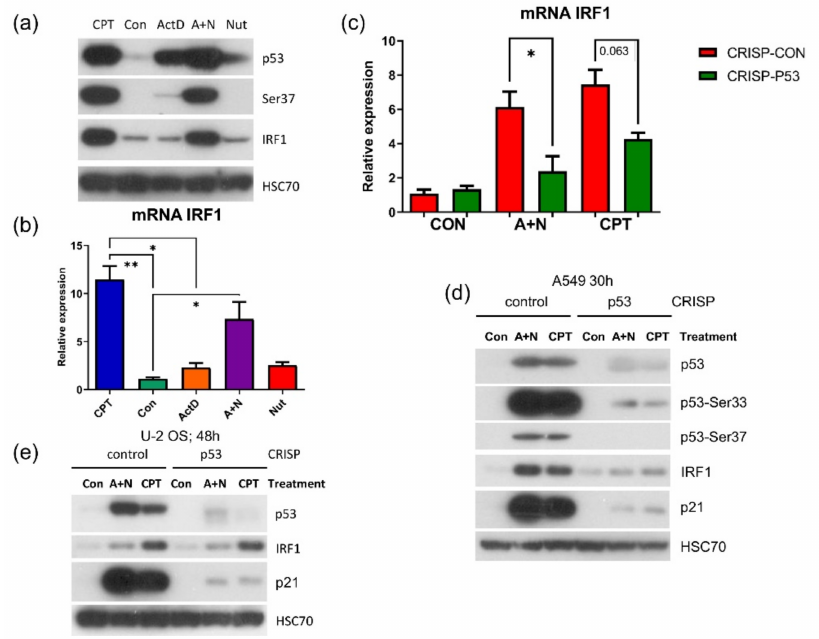
Figure 10. In A549 cells p53 participates in the induction of IRF1 transcription factor. ( a ) Western blot demonstrating expression of p53, its form phosphorylated on Ser37 and of IRF1 protein in A549 cells treated as indicated for 48 h. ( b ) Measurement of relative IRF1 mRNA level in A549 cells exposed to indicated substances or their combinations for 30 h. Statistical differences in expression was calculated by Kruskal-Wallis statistic test with uncorrected Dunn’s test (* p < 0.05) ( c ) Relative IRF1 mRNA levels in p53 knockdown cells (CRISP-p53) or the control cells for knockdown (CRISP-Con) exposed to A + N or CPT for 30 h ( p values were calculated by Kruskal-Wallis statistic test with uncorrected Dunn’s test (* p < 0.05, ** p < 0.01). ( d ) Expression of indicated proteins (or p53 phosphorylated on Ser33 or Ser37) in p53 knockdown (CRISP) A549 cells or in controls for knockdown. Cells were exposed to A + N or CPT for 30h. ( e ) Expression of p53, IRF1 and p21 in U-2 OS cells with